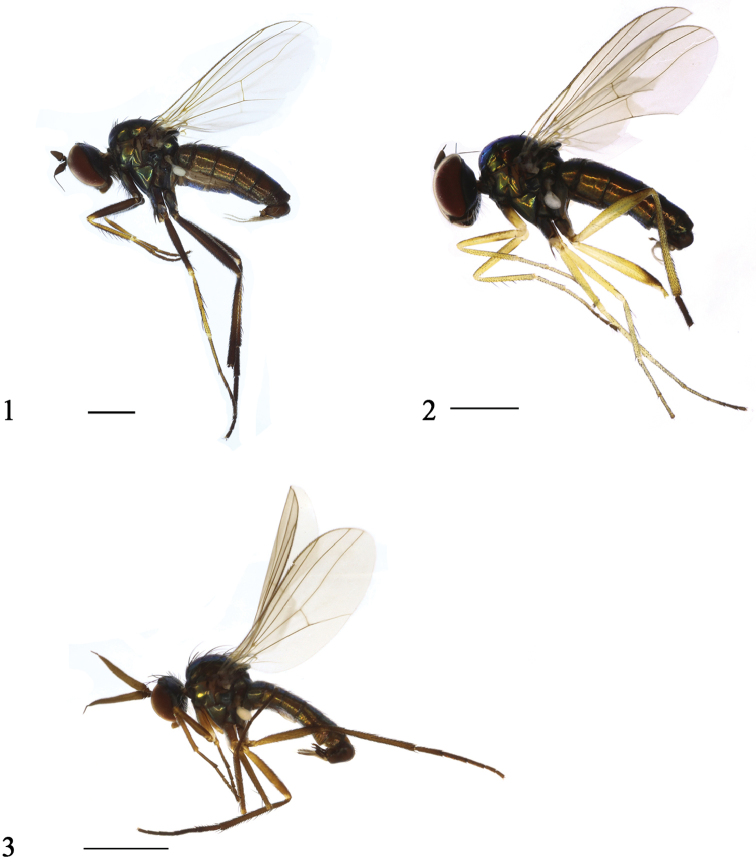
Habitus, lateral view. 1Rhaphiumgangchanum sp. n. male 2Rhaphiumtianshuiense sp. n., male 3Rhaphiumshaliuhense sp. n., male. Scale bars: 1 mm.